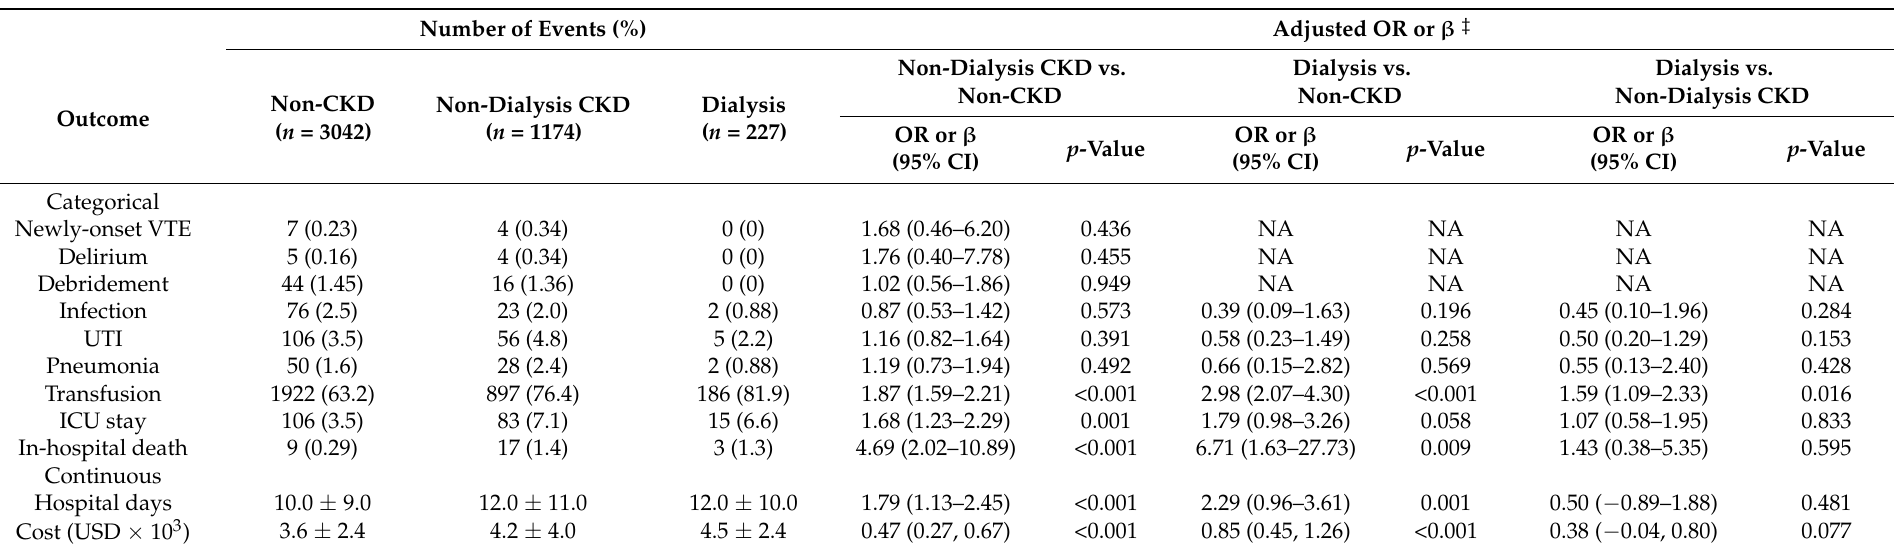
Table 2. In-hospital outcomes of diabetic patients with shoulder arthroplasty according to renal function